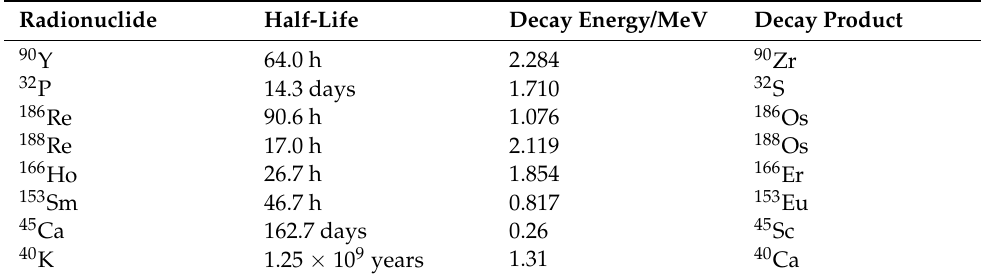
Table 1. Characteristics of various beta-emitting radionuclides. Radionuclide Half-Life Decay Energy/MeV Decay Product 90 Y 64.0